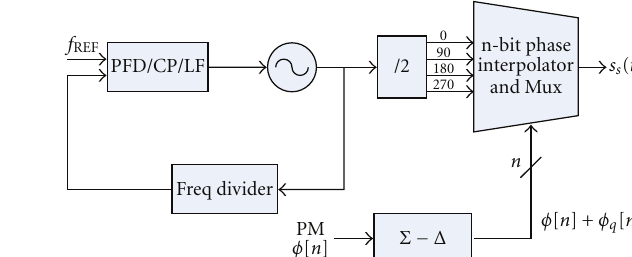
Figure 2: Two-point FM in an all-digital PLL [13].